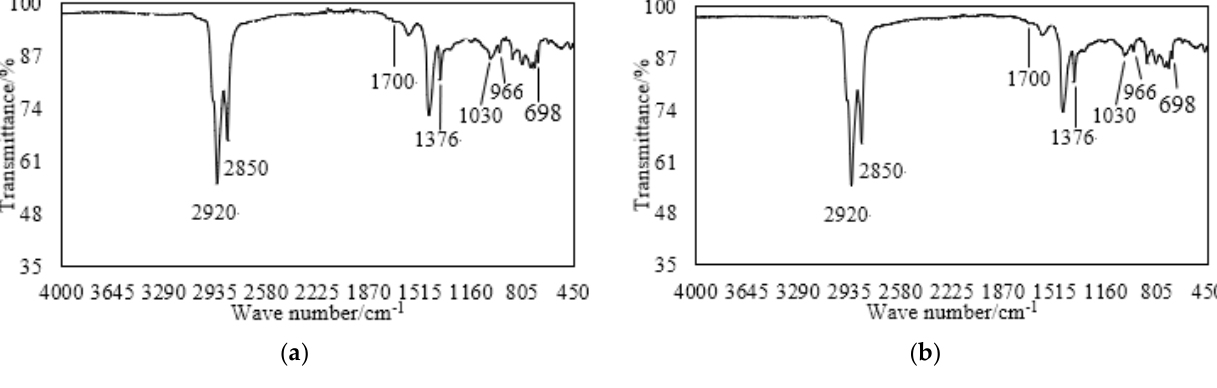
Figure 12. FTIR spectrum of asphalt extracted from short-term aged mixture: ( a ) BFSMA-13, ( b ) LFSMA-13.